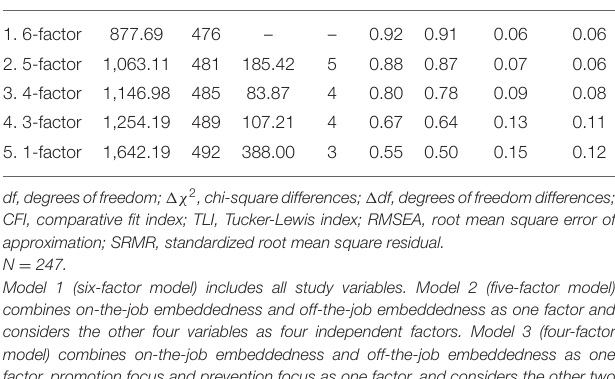
TABLE 2 | Results of confirmatory factor analysis of study variables.